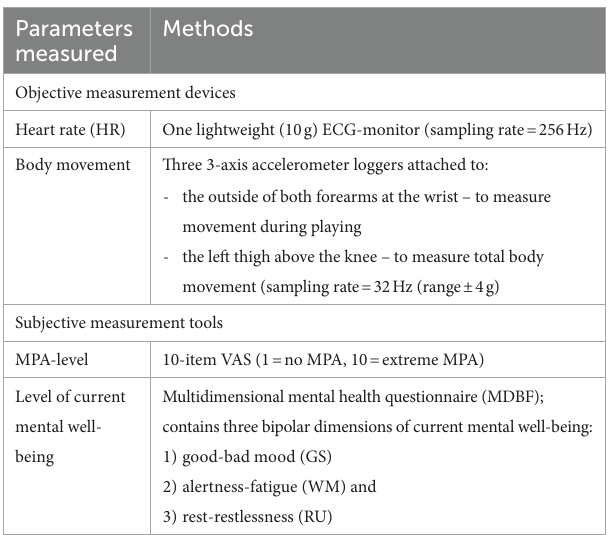
TABLE 2 Measurement methods and